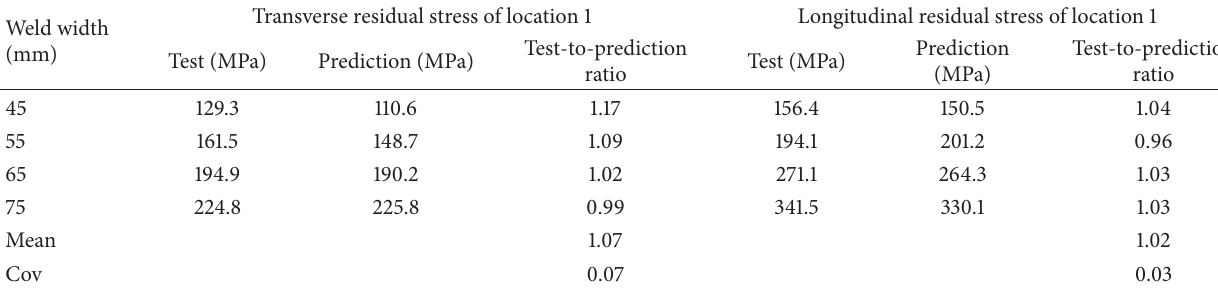
Table 4: Simulation